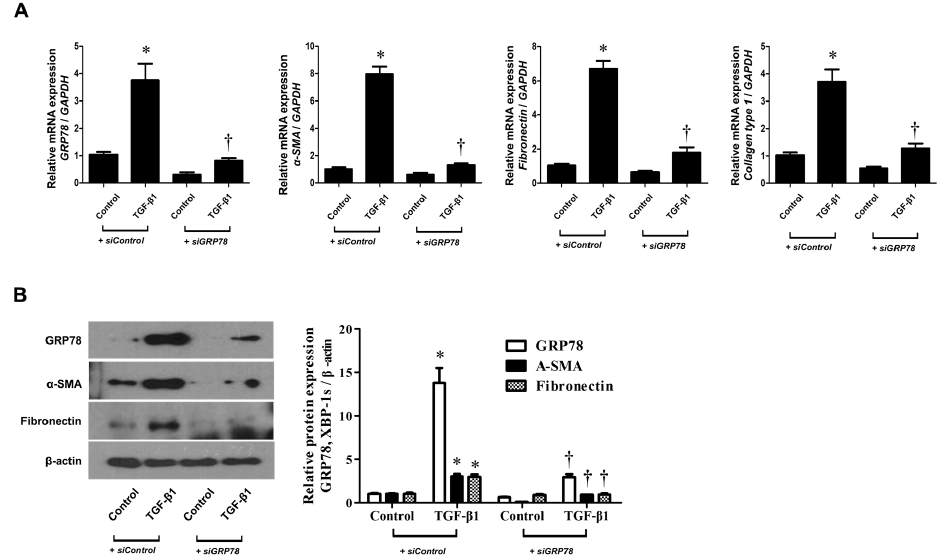
Figure 3. 4-PBA inhibits myofibroblast differentiation and inhibits the TGF- β 1-induced production of extracellular matrix components in nasal fibroblasts. ( A ) Nasal fibroblasts were pre-treated with 4-PBA (2.5-10 mM) for 1 h and were stimulated with TGF- β 1 (5 ng / mL) for 24 h. Relative mRNA expression of a-SMA, myofibroblast marker; fibronectin and collagen type I, extracellular components; was determined by Real-time PCR. Data were normalized to GAPDH levels. ( B ) Protein expression of a-SMA, fibronectin and collagen type I was analyzed by Western blotting. ( C ) Soluble collagen was determined using the Sircol assay. Cells treated with TG (2 µ M) were used as a positive control. Data are presented as mean ± SEM and are representative of at least three independent experiments. * p < 0.05 vs. control, † p < 0.05 vs. TGF- β 1 treatment, # p < 0.05 vs. TG treatment.